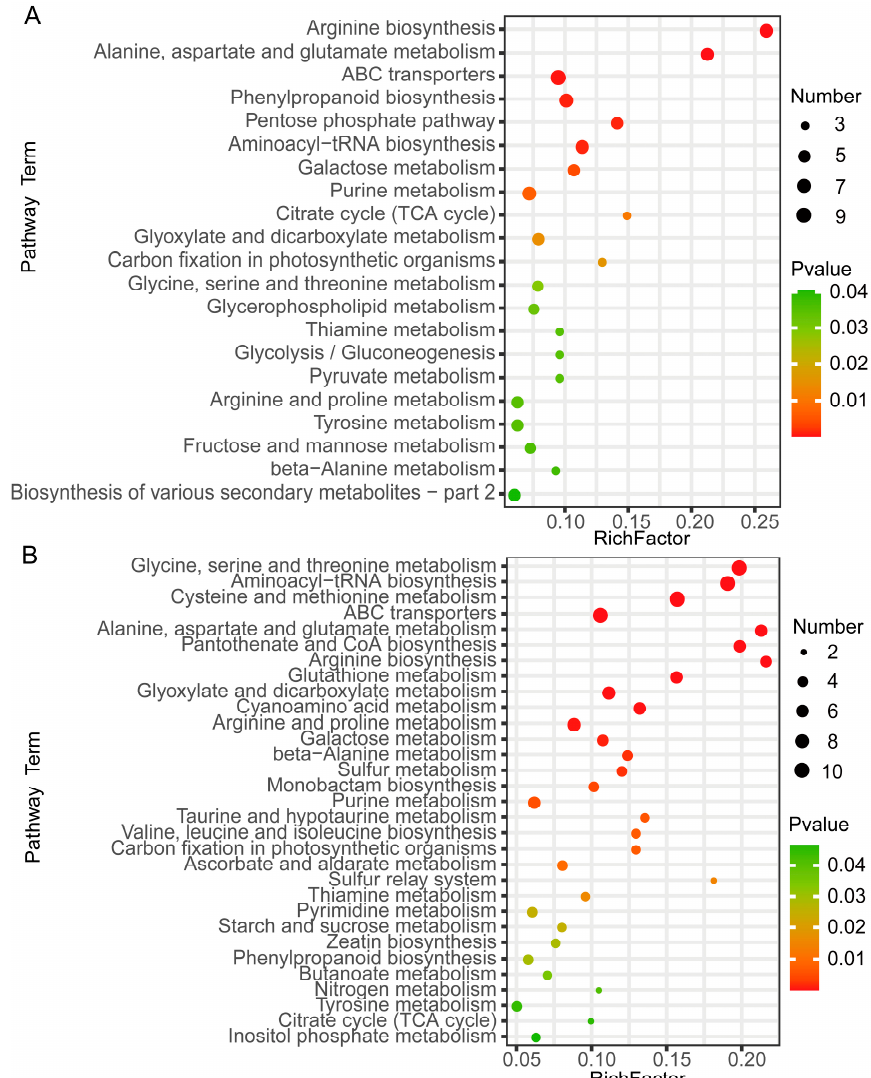
Figure 3. Enriched KEGG pathways with DAMs based on p -value < 0.05. ( A ) LC-MS/MS. ( B ) GC-MS/MS. The abscissa represents the rich factor: DAMs/total DAMs number. The size of the dot indicates the number of DAMs.